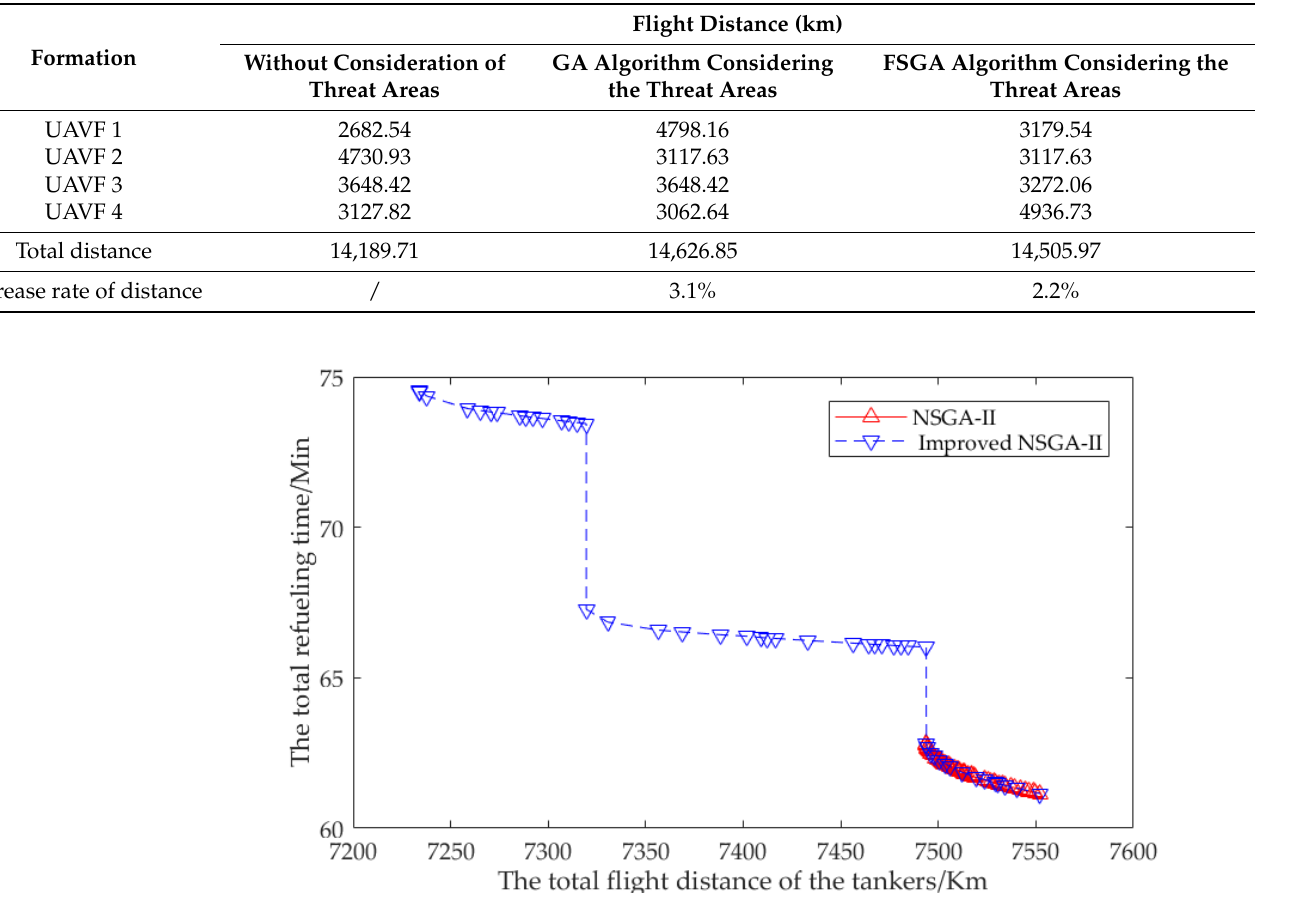
Figure 12. Results of the Pareto solution by the improved NSGA-II and NSGA-II. Through calculation, the Pareto solutions of infinite crowding distance in NSGA-II are (7552.20, 61.15) and (7319.52, 67.27). The Pareto solutions of infinite crowding distance